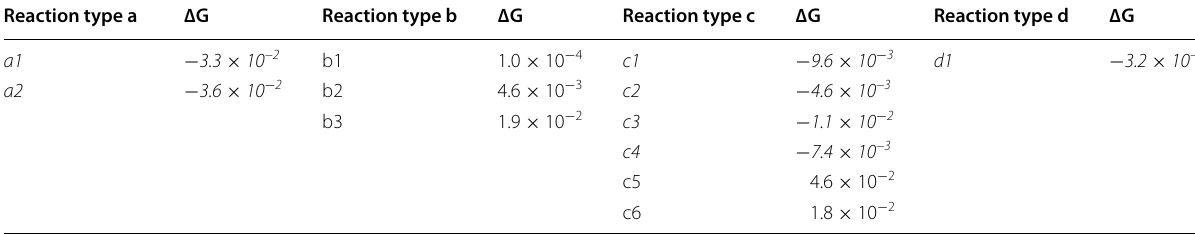
Table 1 Gibbs free energy change (∆G) of twelve reaction pathways unit: Kcal/mol Reaction type